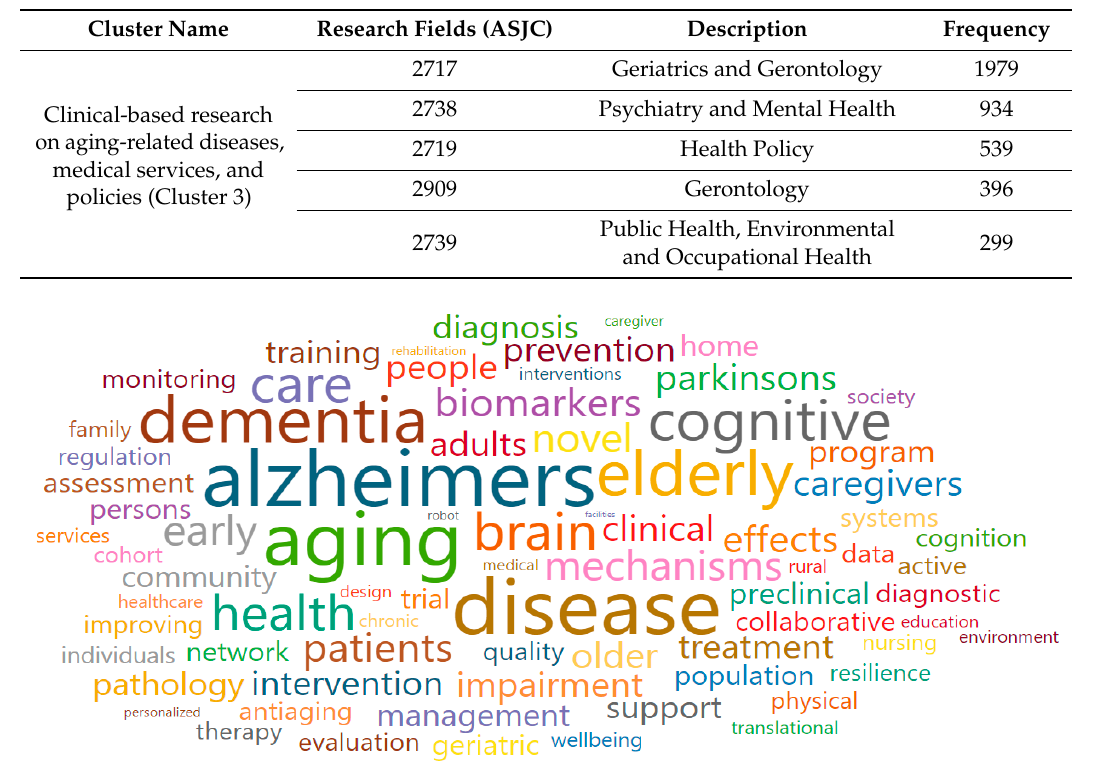
Figure 8. Words cloud in Clinical-based research on aging-related diseases, medical services, and policies (Cluster